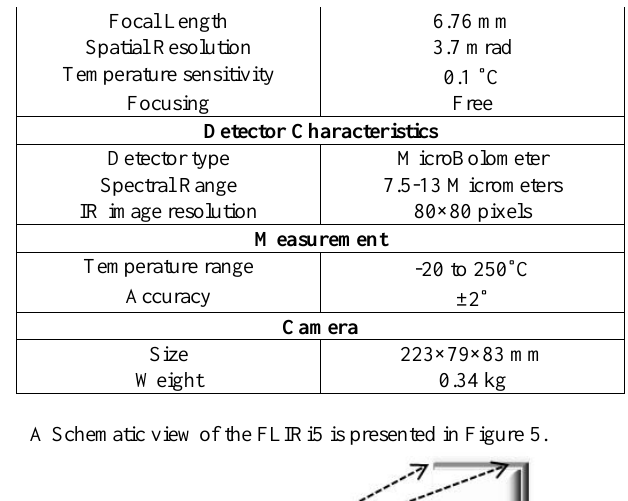
heights as above-mentioned (Figure 8).